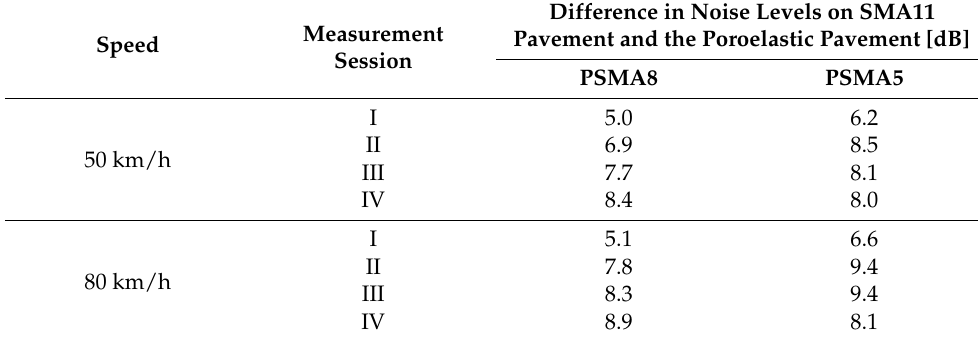
Figure 27. Comparison of pavement noise in four measurement periods. Table 11. Differences in noise levels between SMA11 and PSMA8/PSMA5 pavements.